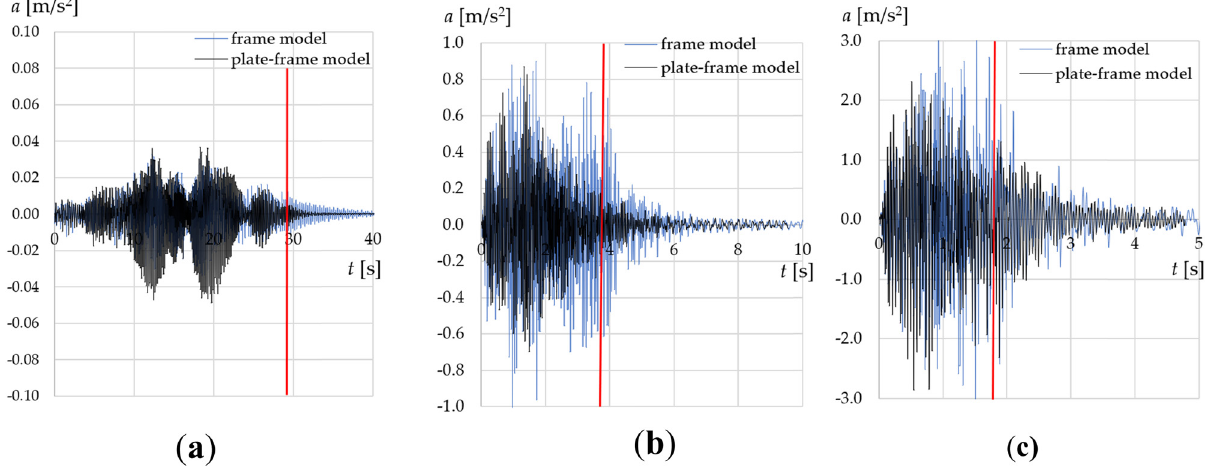
Figure 7: Variances of the acceleration over time of the node at the middle of the span length during the transit of the set of locomotives ST43 – ST45 at ( a ) v = 10 km/h, ( b ) v = 80 km/h and ( c ) v = 160 km/h. The vertical line denotes the moment the locomotive leaves from the